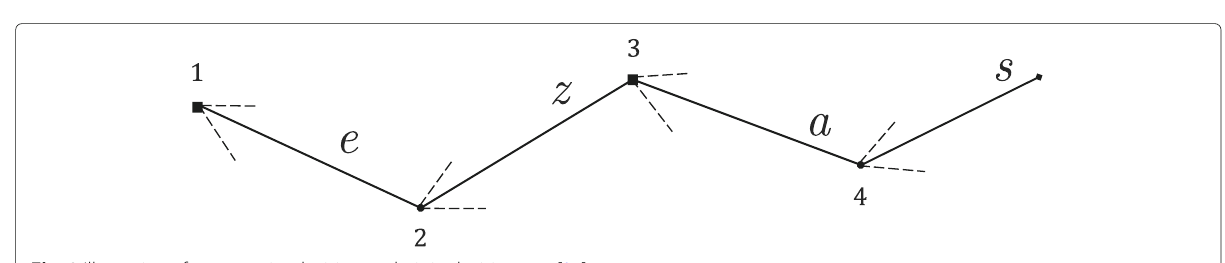
Fig. 2 Illustration of preposterior decision analysis in decision tree